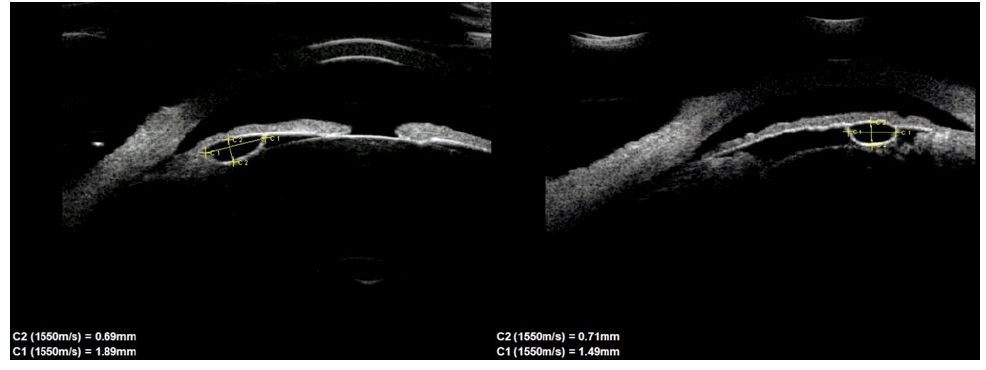
Figure 5. Peripheral cyst.